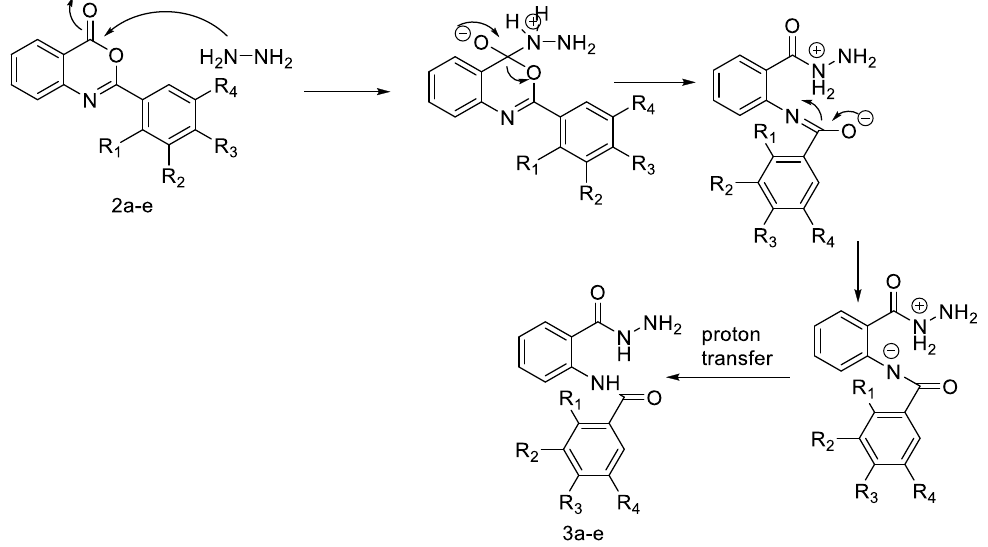
Figure 1. Attack of hydrazine hydrate of carbonyl against benzoxazine ring.